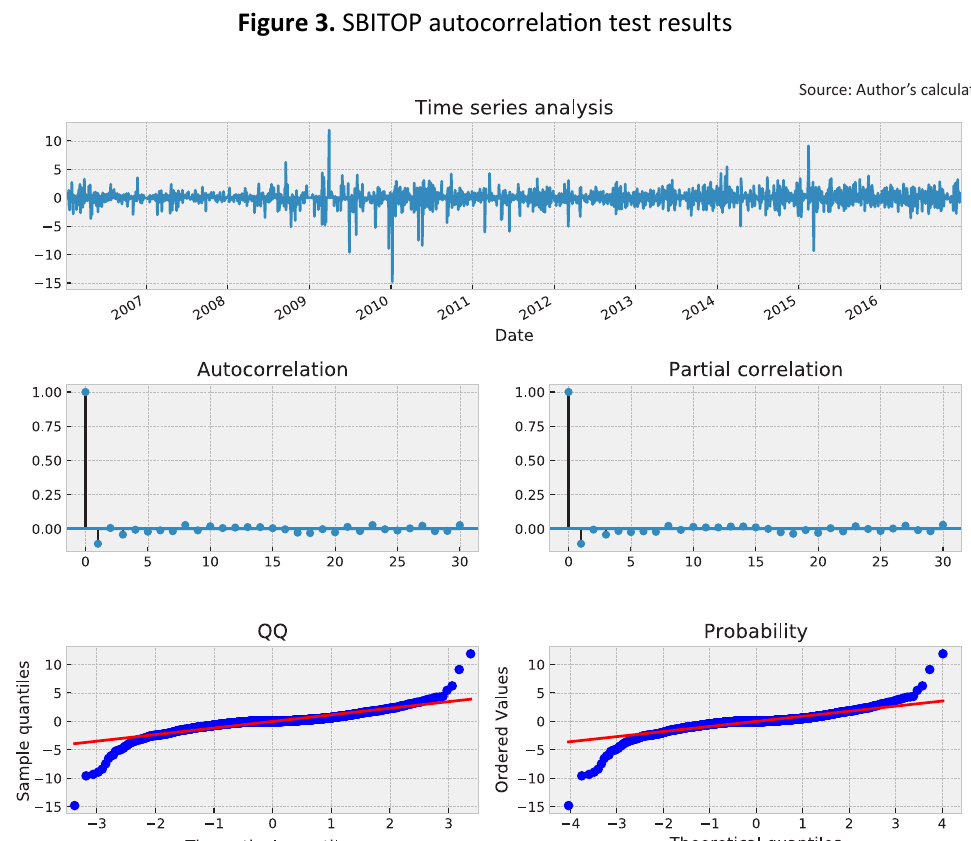
Figure 4. SAX autocorrelation test